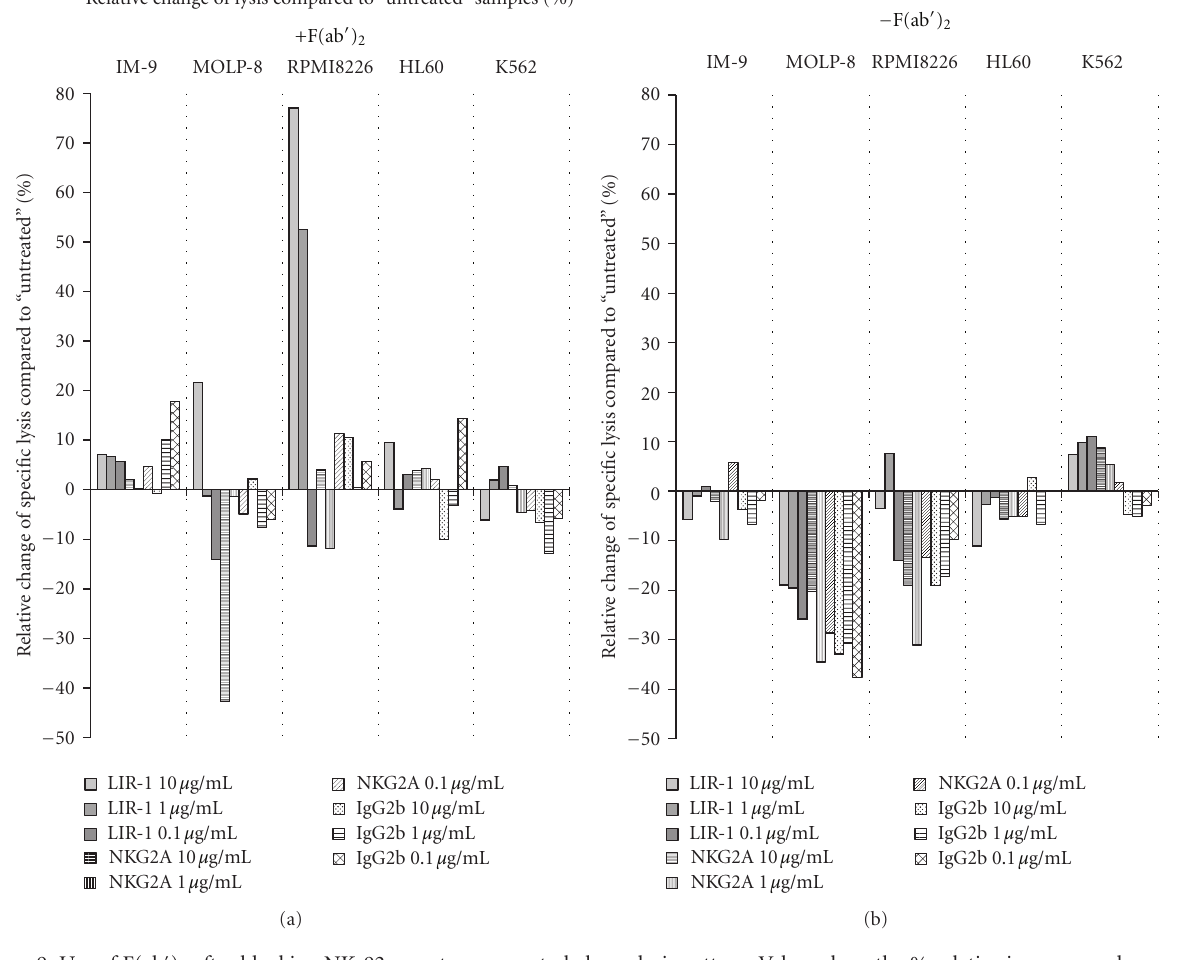
Figure 9: Use of F(ab (cid:3) ) 2 after blocking NK-92 receptors seems to balance lysis pattern. Values show the % relative increase or decrease of target cells lysis in a standard 4-hour CRA, calculated as follows: % relative change of specific lysis = [(% specific lysis “antibody”) − (% specific lysis “untreated”)]/[% specific lysis “untreated”]. Though no concentration of the used mAbs showed a significant change in tumor lysis, interesting di ff erences in the resulting lysis-patterns could be detected. (a) Apart from outliers, use of F(ab (cid:3) ) 2 evens out mAb e ff ects in the blocking experiments, leading to values that oscillate close to the origin in both directions. (b) Sparing F(ab (cid:3) ) 2 decreases specific lysis, predominantly for MOLP-8 and RPMI8226